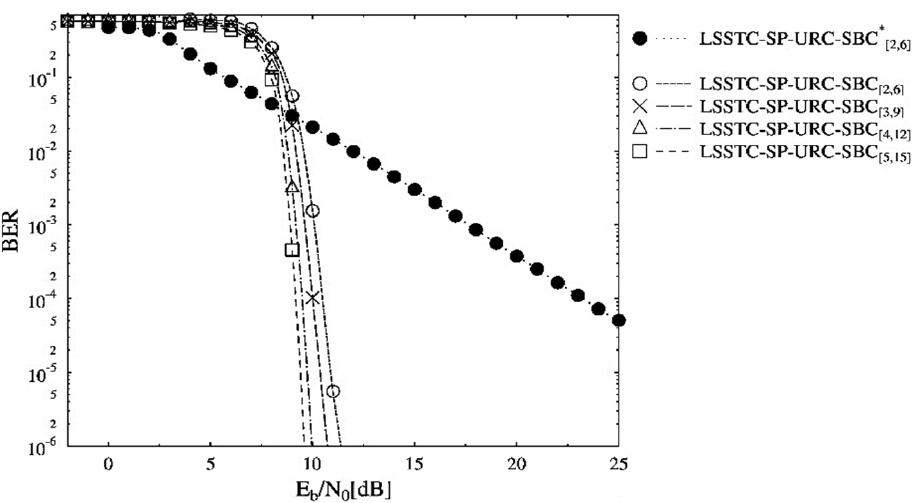
Figure 4. BER versus E b / N 0 performance curves of the SBC schemes presented in Table 2.